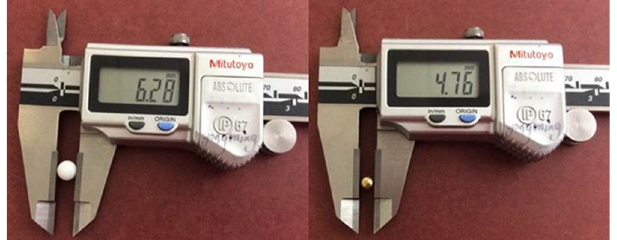
beads.FIG. 18. Perturbing objects employed in the measurement with their dimensions measured by caliper. (Left: Teflon. Right: Brass).